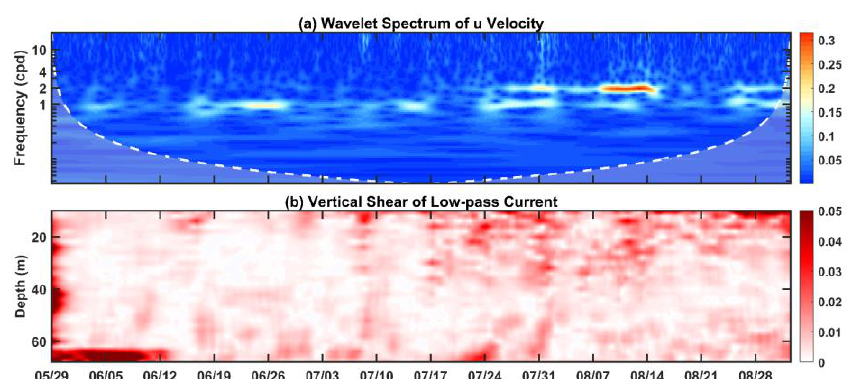
Figure 9. ( a ) Wavelet power spectra of baroclinic zonal component during observation period at 60 m depth. The white dashed line indicates the cone of influence. The white dashed lines and the shaded regions below are suspect and potentially influenced by edge effects. The frequency unit is cycles per day (cpd), and the spectrum uses L1 normalization to show a more accurate representation of the signal. ( b ) The vertical profile of 7-day low-pass vertical shear variance (unit: 1/s 2 ).